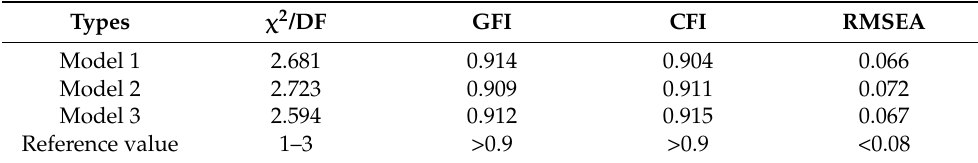
Table 6. Goodness-of-fit statistics of the model.